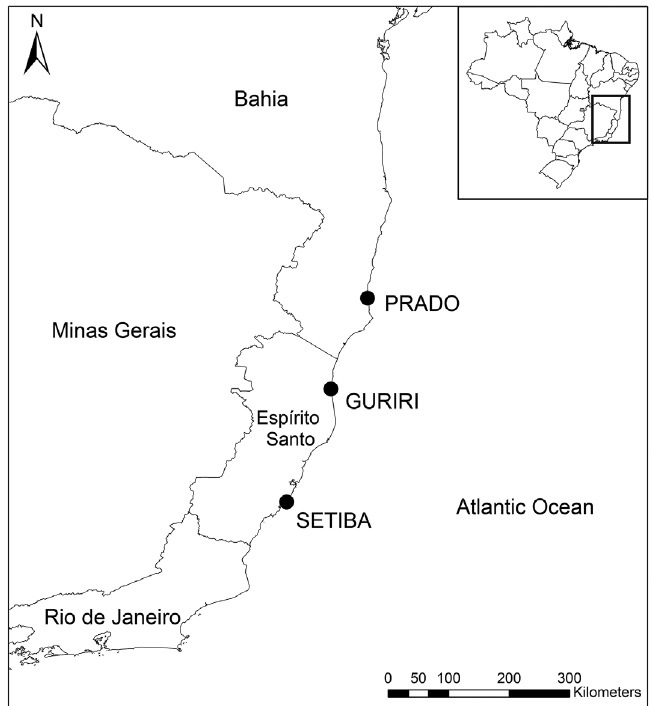
Figure 1 - Map showing restinga habitats where Phyllodytes luteolus were collected: Guriri (18°41’S and 39°45’W) and Setiba (20°35’S and 39°13’W), in the state of Espírito Santo, and Prado (17°18’S and 39°13’W), in the state of